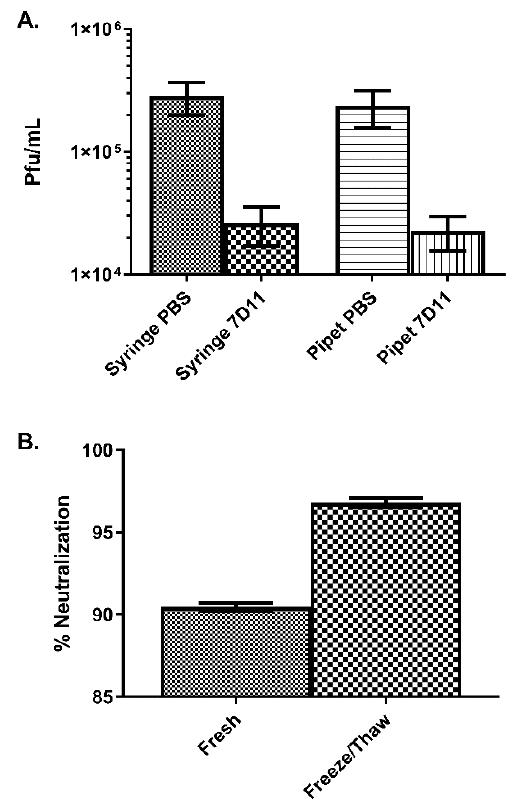
Figure 3. Titration of inoculum in the presence or absence of anti-MV antibody. ( A ) Back titration of the inoculum was performed by either pipetting or expunging the inoculum through a syringe subsequent to plaque assay. Antibody known to neutralize the MV form of monkeypox virus (7D11) was used to evaluate the morphogenic content (EV and MV). ( B ) The inoculums subsequently underwent four sequences of a freeze/thaw and three sonication cycles, after which a neutralization assay was performed.